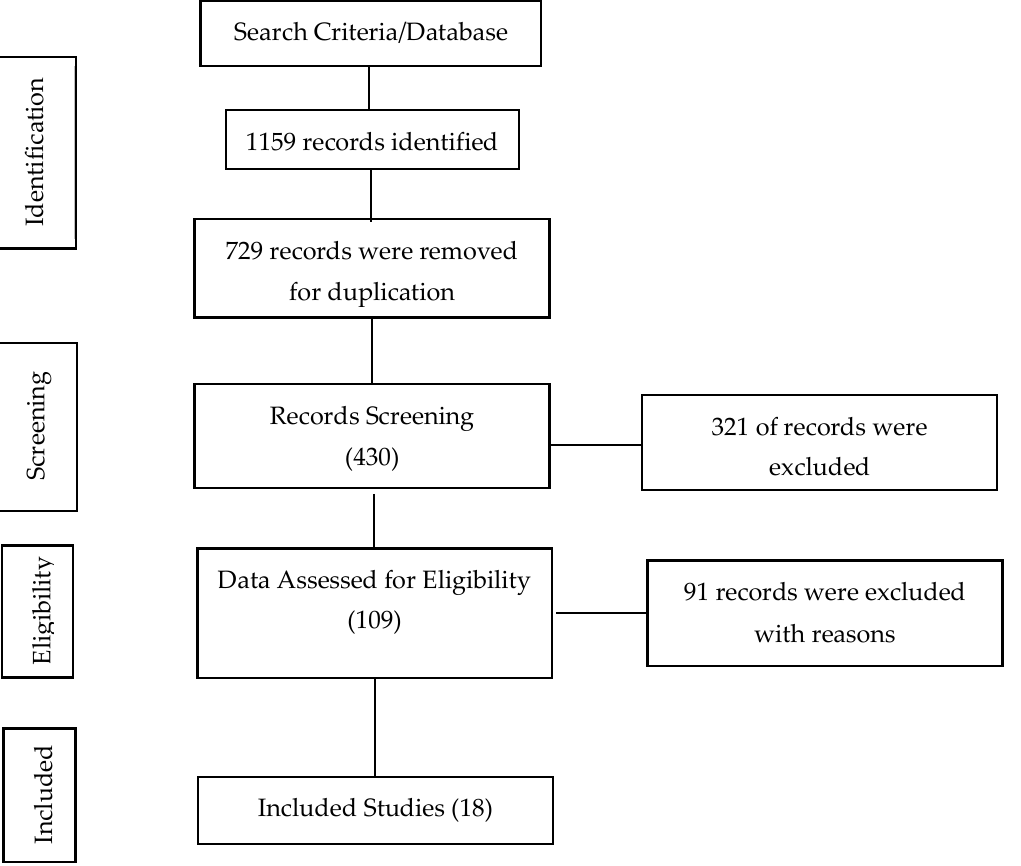
Figure 1. PRISMA flow diagram of search study selection process.